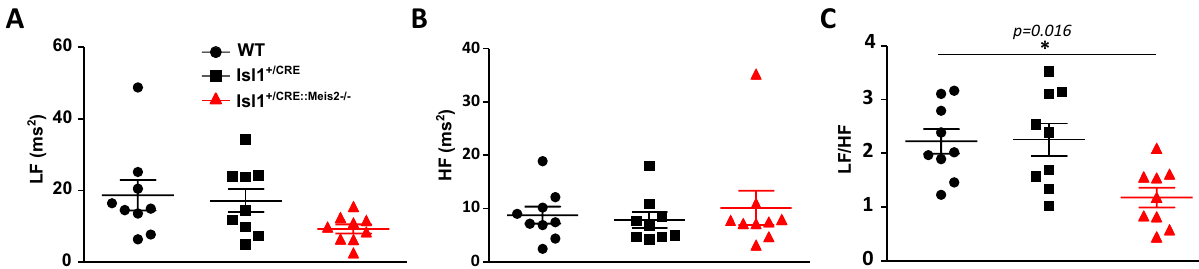
Figure 3. Decreased sympathovagal activity in Isl1 +/CRE ::Meis2 LoxP/LoxP mice. HRV analysis of WT, Isl1 +/CRE and Isl1 +/CRE ::Meis2 LoxP/LoxP vigil mice. Low-frequency band (LF) ( A ), High-frequency band ( B ) and sympathovagal index LF/HF ( C ) were obtained at baseline by fast Fourier transform and revealed a decrease of sympathovagal activity on heart rhythm. n = 7–9 mice in each group. * p ≤ 0.05 to WT.